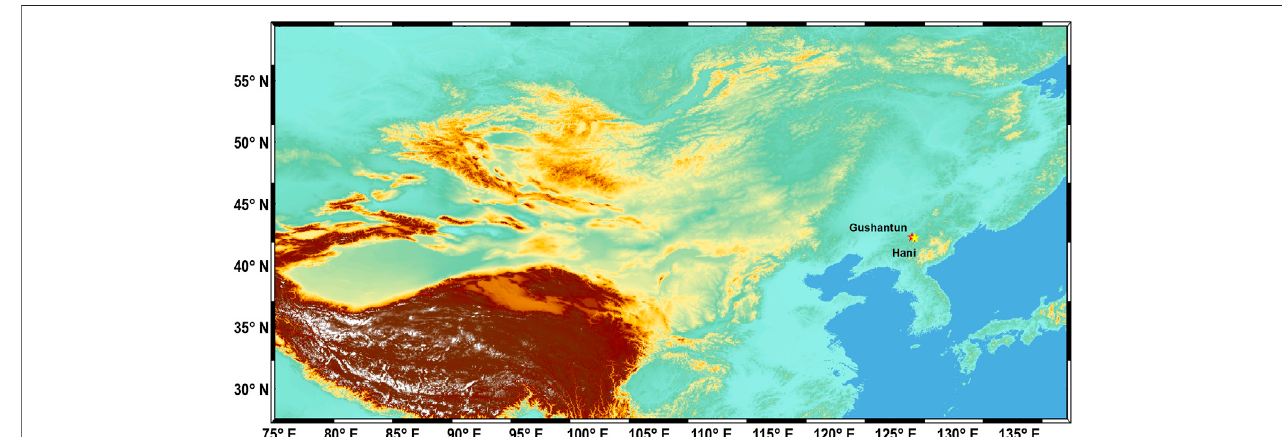
FIGURE 1 | Location of the Gushantun (red star) and Hani peat (yellow